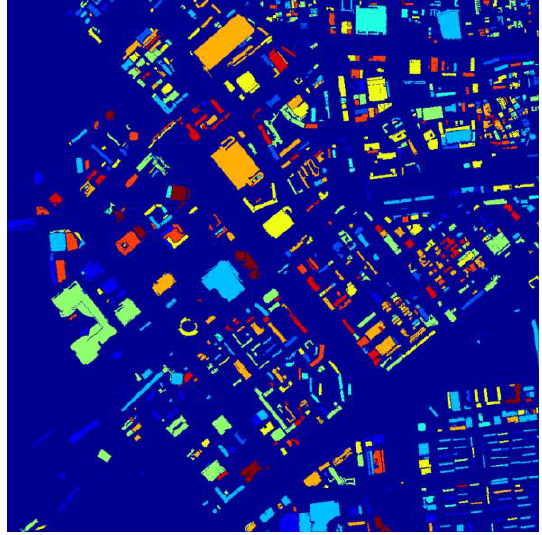
Figure 12. Result in the step 3